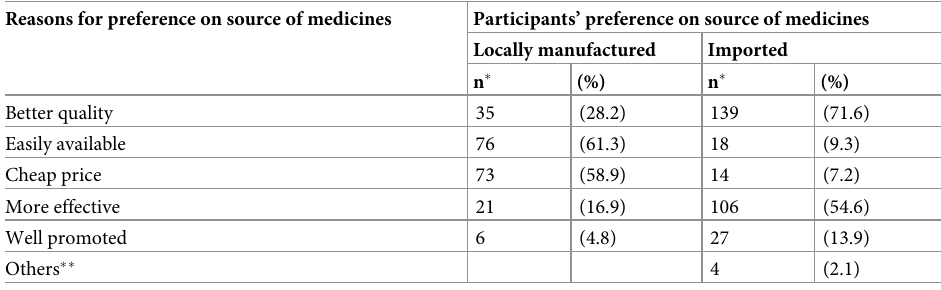
Table 4. Participants’ stated reasons for their preferences on source of